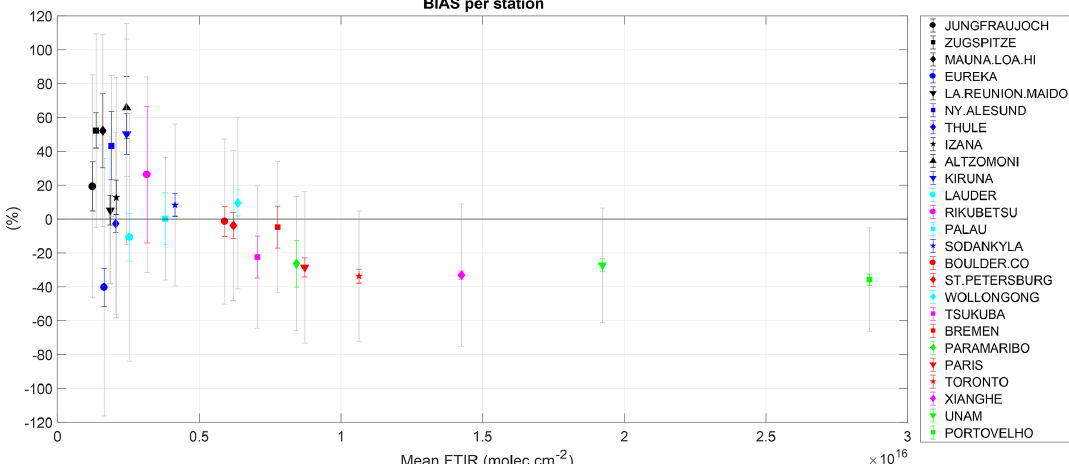
Figure 3. BIAS at each station (in per cent) as a function of the mean FTIR total columns (molec.cm − 2 ). The grey bars are the systematic uncertainty of the differences σ syst , and the coloured error bars are the 2 σ error in the bias ERR B . Black markers are for mountain stations; blue markers are for Arctic stations; cyan markers are for Oceania, Australia, and New Zealand; magenta markers are for China and Japan; red markers are for mid-latitude Europe and North America; and green markers are for Central and South America.